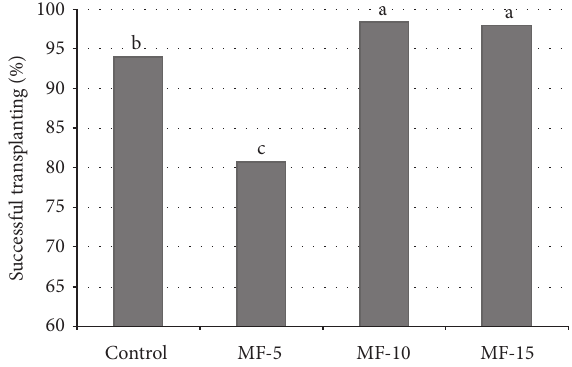
Figure 1: Pulsed electromagnetic field effect on percentage of successful transplanted seedlings. Seeds have been exposed for 0, 5, 10, and 15 minutes in magnetic field. Means followed by the same letter for treatments are not significantly different according to the LSD 5% test. Control: untreated seeds; MF-5, MF-10, and MF-15: seeds treated with pulsed electromagnetic field for 5 min, 10 min, and 15min, respectively.